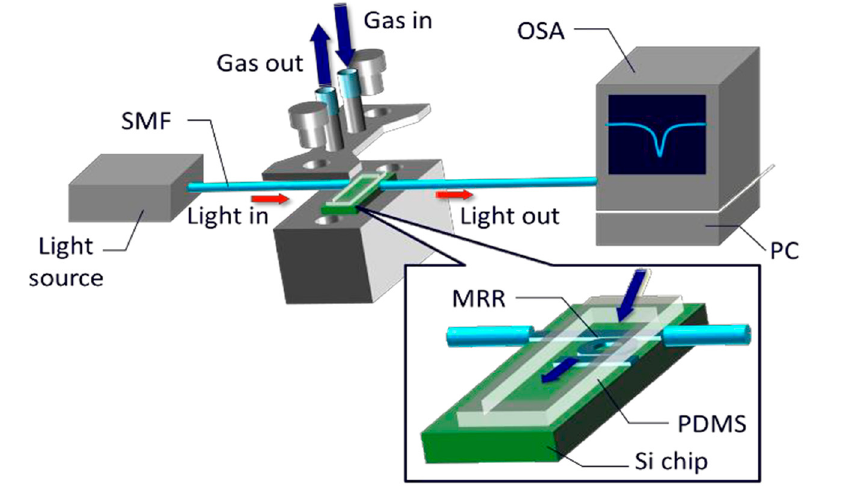
Figure 2. The gas sensing